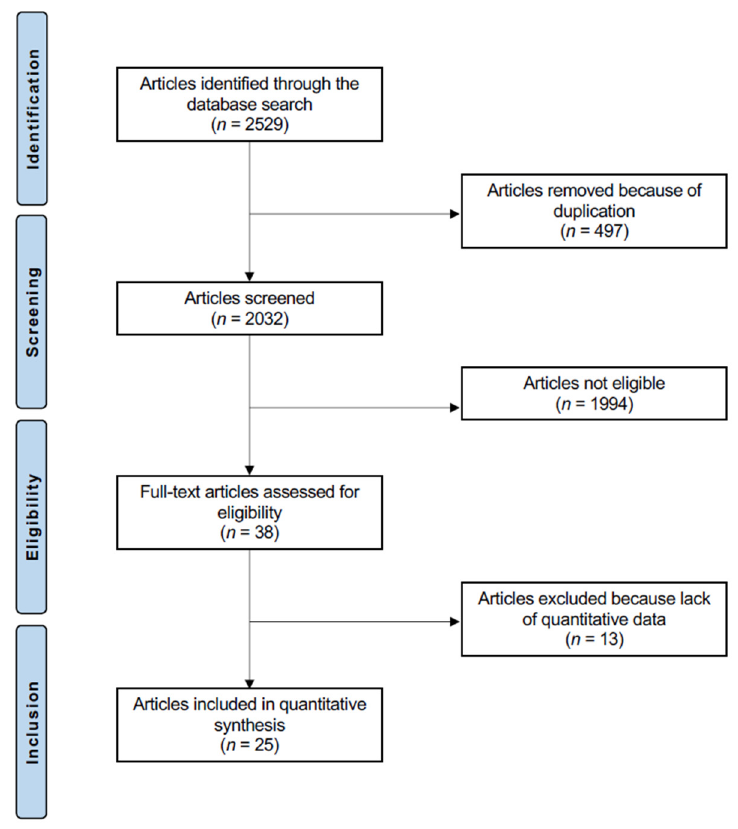
Figure 1. Flow chart of the literature search .